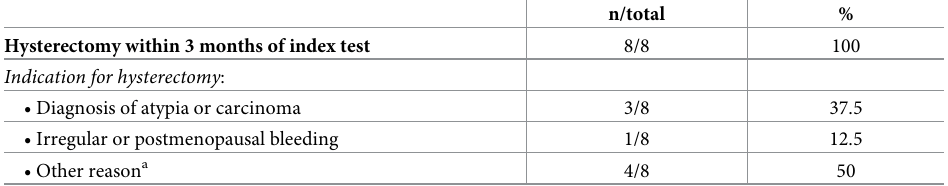
Table 3. Results on follow-up of women who had a hysterectomy within 3 months of initial diagnosis of non-atyp- ical endometrial hyperplasia.